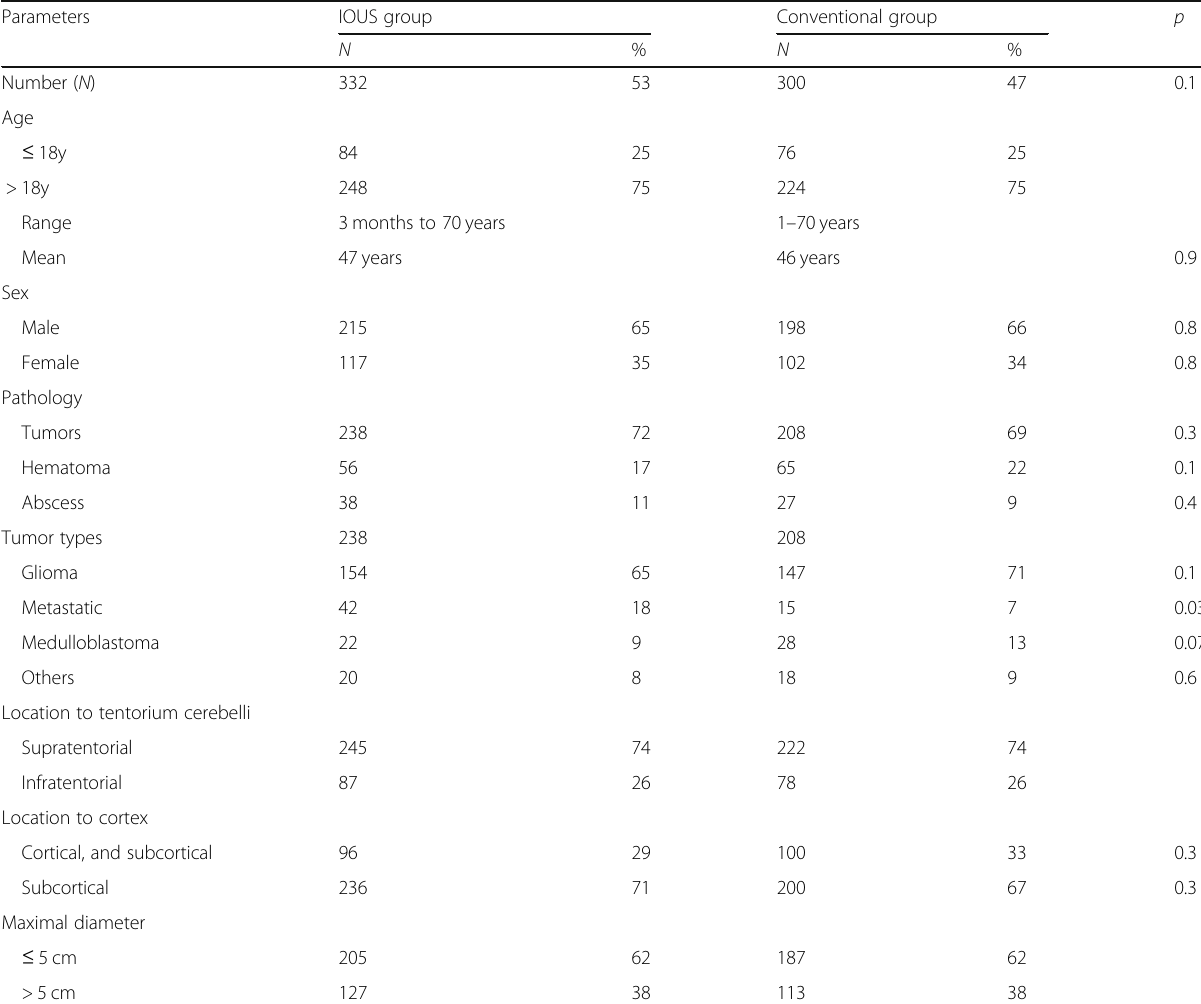
Table 1 Study population